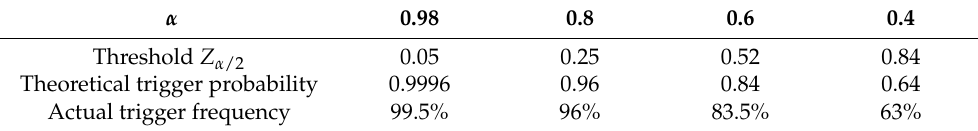
Table 1. Comparison of trigger frequency in the steady-state system for different α . α